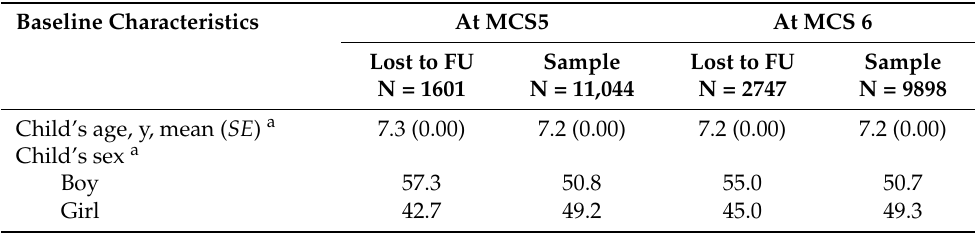
Table A1. Comparison of baseline characteristics (at 7 years) between the followed sample and those lost to follow-up (FU) at 11 and 14